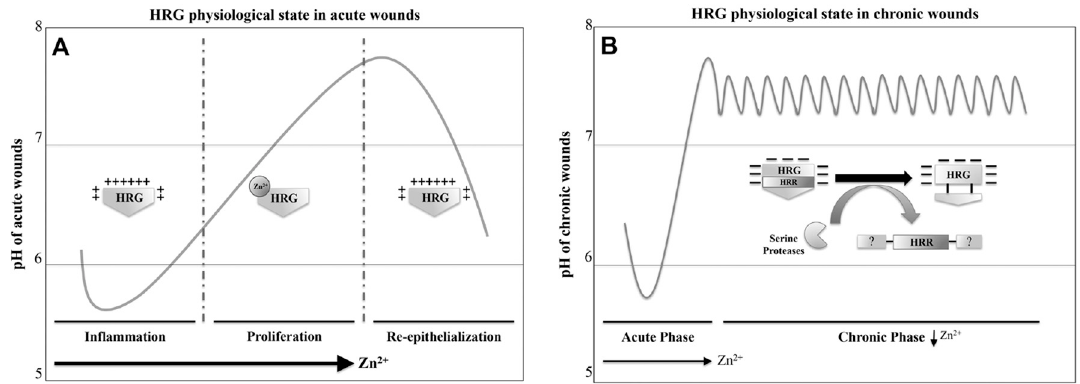
Figure 3. Potential physiological representation of HRG during the different stages of acute or chronic wounds. HRG is exquisitely sensitive to changes in environmental pH, given the charged state of the histidines controlling its ability to coordinate with Zn 2+ and thus regulating its previously mentioned activities such as its antimicrobial properties [35,49]. In addition, the release of peptide fragments containing the HRR are unlikely to contribute to its antimicrobial or anti-angiogenic activities in acute wounds, as there appears to be proteolytic protection of HRG during all stages of acute wound healing, possibly due to the positive charge generated during the inflammation and re-epithelialization stage or Zn 2+ elevation during the proliferation stage (Figure 3A) [6,9,11,12]. Therefore the exact role of fragments released in chronic wounds remains unclear, as the alkali and hypozincemia environment does not favor the required charge associated with antimicrobial activity or Zn 2+ coordination with its anti-angiogenic peptide [6,11,12,35,49]. In addition to plasmin and elastase, other proteases such as matrix metalloproteinases (MMP) -8, MMP-9, cathepsin G and urokinase-type plasminogen activator (uPA) have shown harbor-elevated activity in chronic wounds and therefore could be prime candidates for the proteolytic breakdown of HRG observed in the chronic wound fluid fraction [35,50]. Interestingly, the study looked at the activity of these proteases over a pH range and observed optimum activity for most between pH 7–9, with in vivo data from 43 patients’ chronic wound fluid (derived from pressure, leg and diabetic foot ulcers) demonstrating that elastase is the most predominant protease contributing to impaired wound healing [50]. These pH values corroborate with the pH values observed in chronic wounds and therefore reinforce the possibility that proteases that act on HRG are under chronic wound settings (Figure 3B) [6,35]. This suggests HRG function can be regulated throughout the different phases of the acute or chronic wound-healing process. These pH curves in the figures were adapted from Schneider et al. [6].